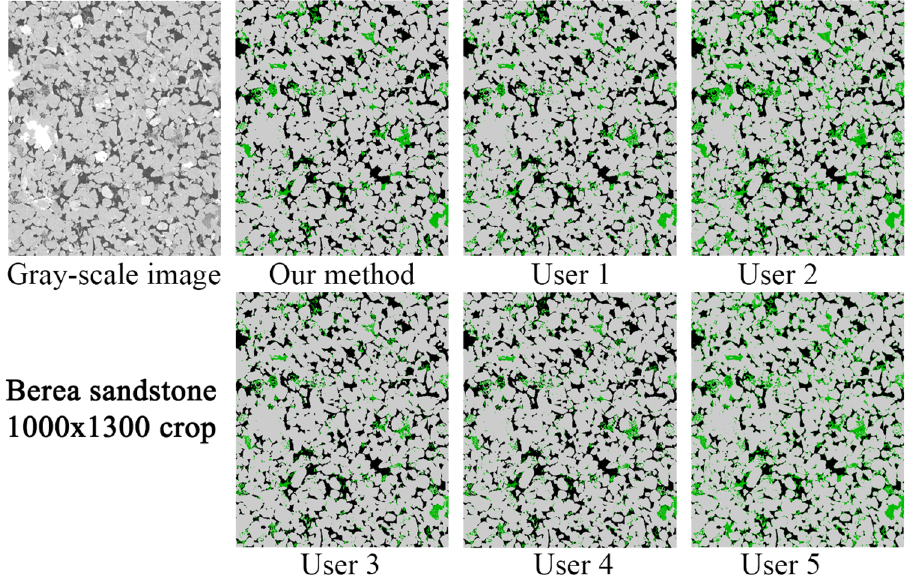
Figure 12. Comparison of segmentation results on a vertical top-half crop of the Berea image where we can see a significant variation in the amount of micro-phase between the different users.